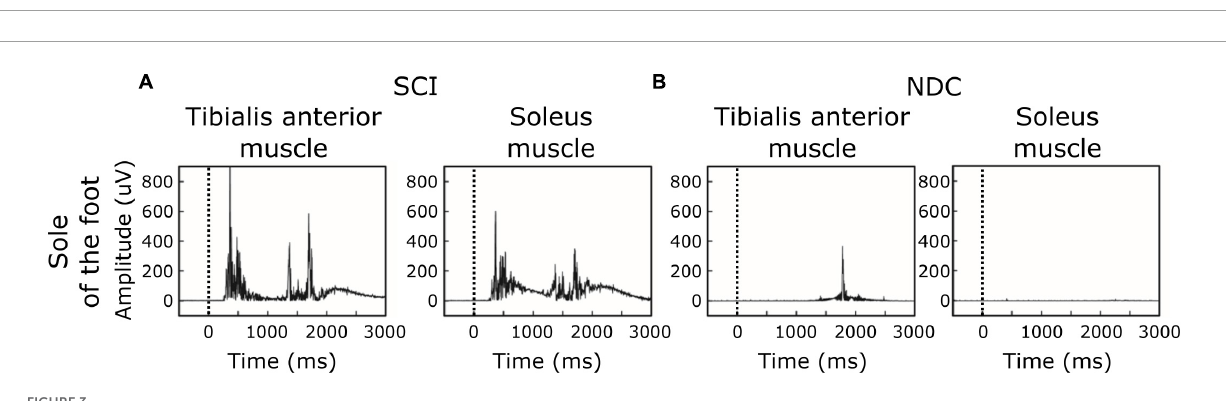
FIGURE3 Individual examples of motor responses. (A,B) Stimulation site: sole of the foot. (A) Ipsilateral EMG-recordings with single reflex events of a participant with spinal cord injury (SCI). (B) Corresponding recordings in a non-disabled control (NDC). The black dashed line indicates the onset of the